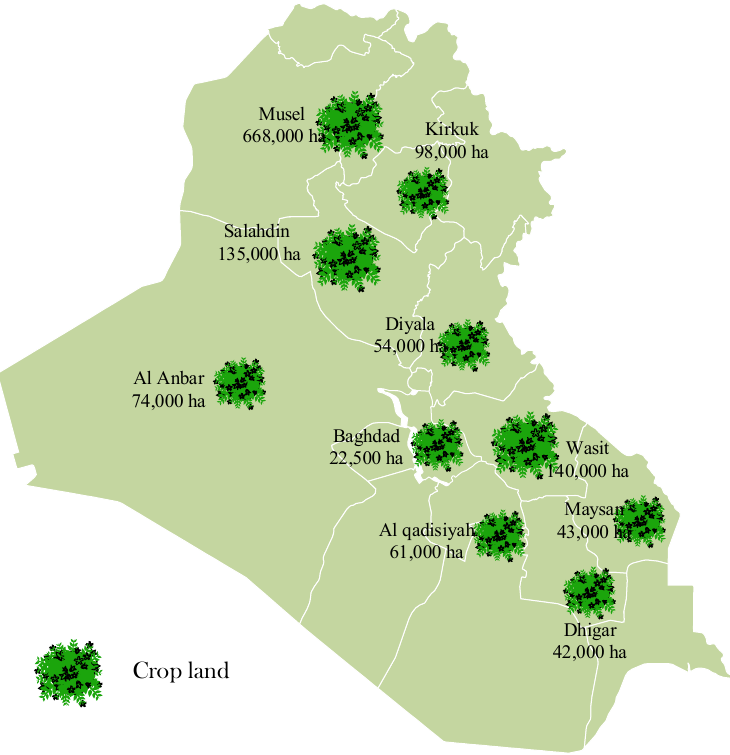
Figure 6. The geographical locations of the most important crops cultivated in Iraq.